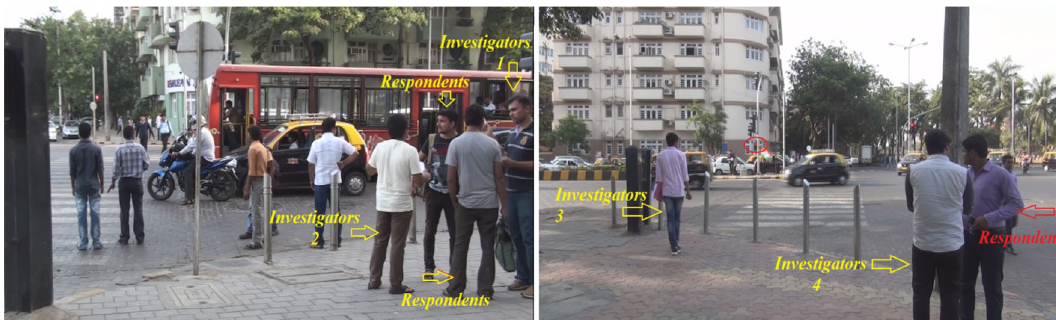
Fig. 2 Selected crosswalk ( E ) and investigators with respondents pedestrians